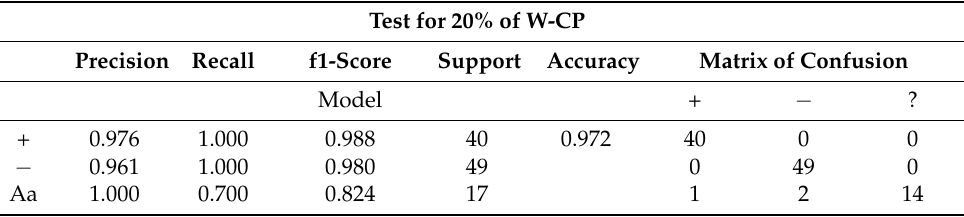
Table 1. Confusion matrix and evaluation criteria for the random forest classifier (RFC) model for the well-characterized portion (W-CP).